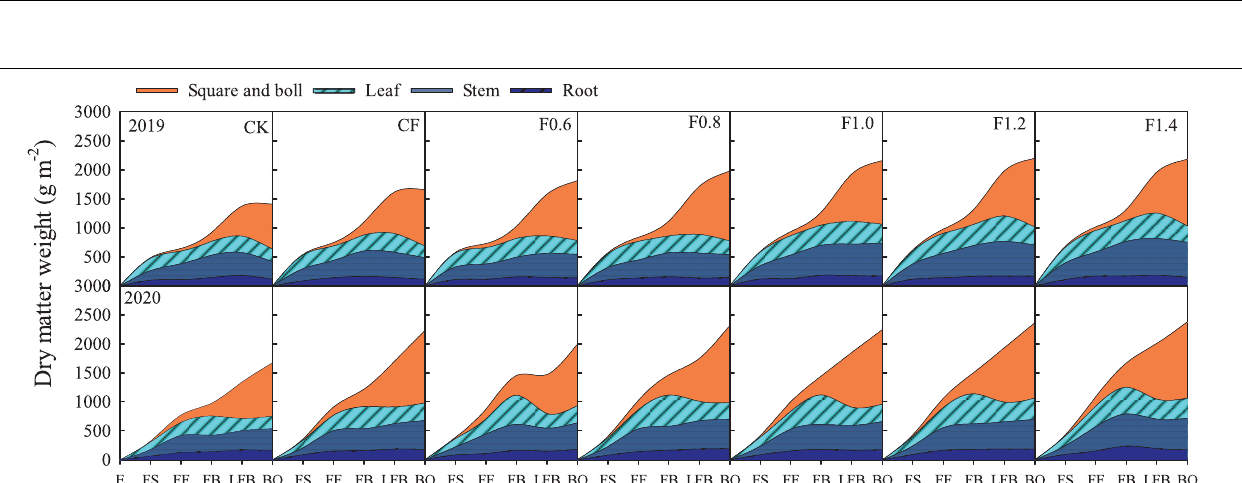
Frontiers in Plant Science |